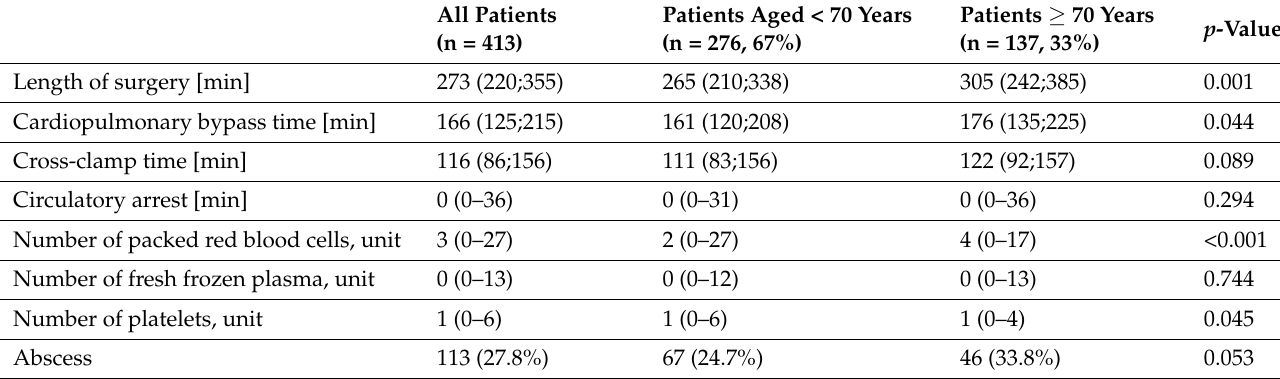
Table 3. Intraoperative data and secondary